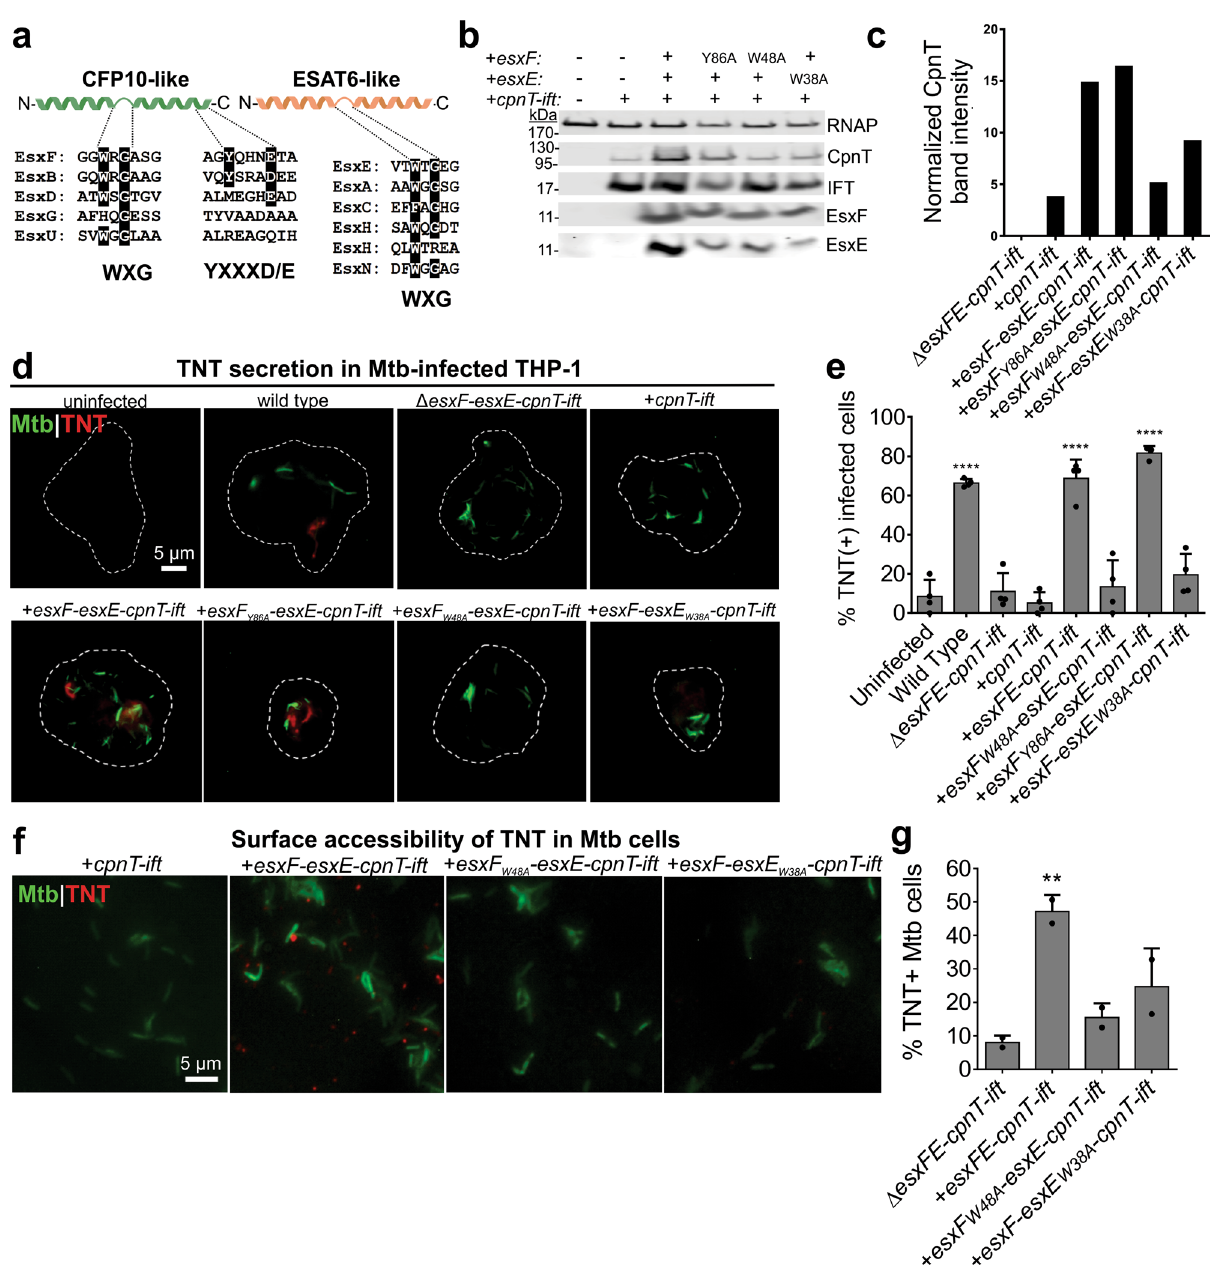
Fig. 2 The WXG motif is required for EsxE-EsxF function. a Sequence alignment of the WXG YXXXD/E motifs in Esx heterodimer pairs of M. tuberculosis . b Immunoblot of Mtb whole-cell lysates probed with antibodies for the indicated proteins. RNA polymerase (RNAP) was used as a loading control. Representative of two experiments c Quanti fi cation of the CpnT bands from the immunoblot in b using ImageJ. d Detection of TNT in the cytosol of Mtb- infected macrophages. Representative fl uorescence microscopy images of THP-1 macrophages 48 h after infection with DMN-trehalose-labeled Mtb. THP- 1 cells were treated with digitonin to only permeabilize the plasma membrane and were probed with anti-TNT antibody (Alexa fl uor-594, red). Representative of four independent experiments. e Quanti fi cation of d . Infected macrophages were scored as TNT + or TNT − based on the presence or absence of bright red punctae and quanti fi ed as % TNT-positive cells. At least 100 cells were analyzed of at least four independent experiments. Data shown is the mean ± SD from four independent experiments. Statistical analysis was performed using one-way ANOVA with Dunnet ’ s multiple comparison test using the uninfected sample as the negative control. P < 0.0001. f Surface acccessibility of TNT of the indicated Mtb strains by fl uorescence microscopy with DMN-trehalose (green), and probed with α -TNT and an Alexa fl uor-594-conjugated secondary antibody. Data are from at least ten fi elds of view from two independent experiments. g Quanti fi cation of f . Percentage of TNT-positive cells out of total bacteria from at least fi ve fi elds of view. N ≥ 1000 bacterial cells total over two independent experiments. Shown is mean and standard deviation from two experiments. The statistical analysis was performed using one-way ANOVA analysis with Dunnet ’ s multiple comparison test using the Δ esxFE-cpnT-ift strain as the negative control. P = 0.016. Source data are provided in the Source data fi